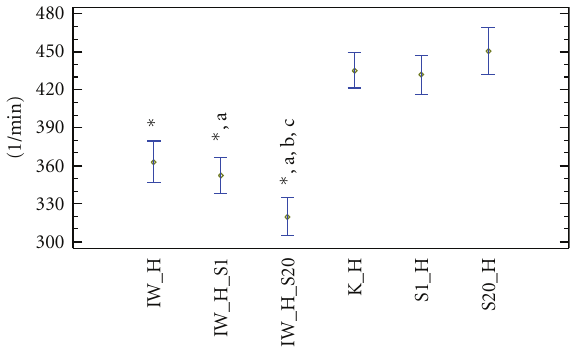
Figure 4: Resting mean heart rate (min − 1 ) in Wistar rats fed- hypercholesterolaemic diet. K H: hypercholesterolaemic control group, IW H: hypercholesterolaemic group receiving ivabradine, S1 H: hypercholesterolaemic group receiving simvastatin at a dose of 1 mg × kg − 1 bw, S20 H: hypercholesterolaemic group receiving simvastatin at a dose of 20 mg × kg − 1 bw, IW H S1- hypercholesterolaemic group receiving ivabradine and simvastatin at a dose of 1 mg × kg − 1 bw, IW H S20: hypercholesterolaemic group receiving ivabradine and simvastatin at a dose of 20 mg × kg − 1 bw, ∗ P < 0 . 05 as compared to control group, (a) P < 0 . 05 as compared to rats receiving simvastatin alone, and (b) P < 0 . 05 as compared to rats receiving ivabradine alone, (c) P < 0 . 05 as compared to rats receiving ivabradine and simvastatin at a dose of 1mg × kg − 1